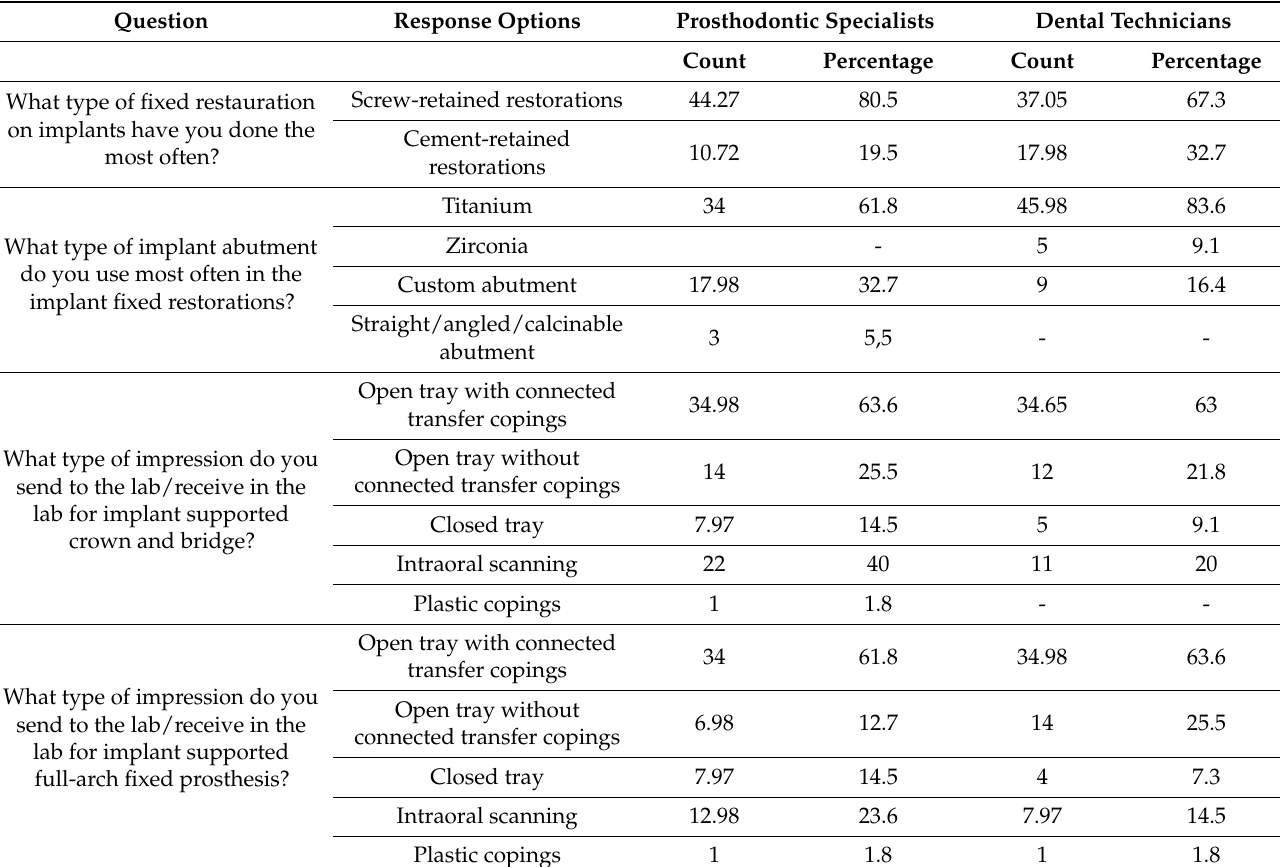
Table 3. Data regarding design and impression technique of the fixed restoration with implant